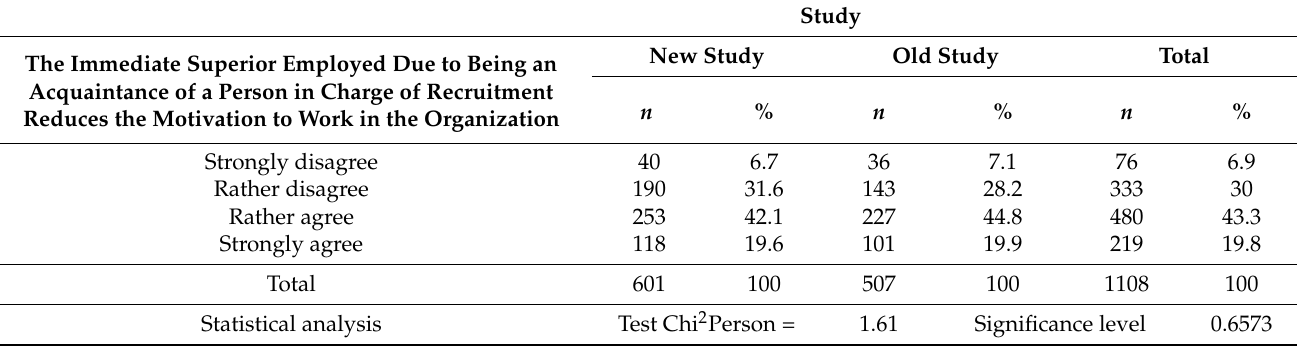
Table 18. Statistical analysis of the assessment of the impact of the immediate superior of the employed person “due to the acquaintance” with the person in charge of the recruitment on the motivation to work in the company depending on the date of the study.